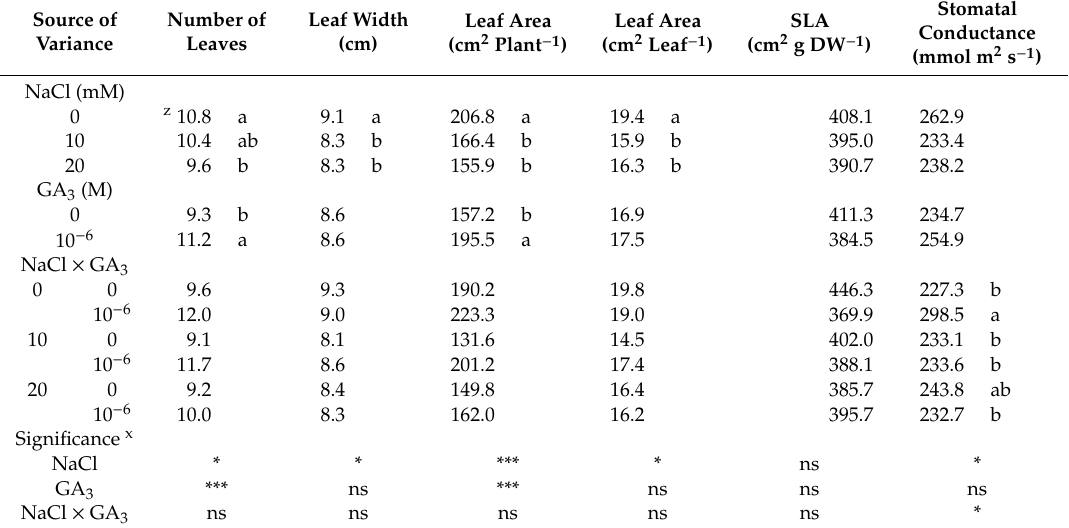
Table 7. Leaf characteristics of rocket plants grown in nutrient solutions containing di ff erent levels of NaCl and GA 3 .